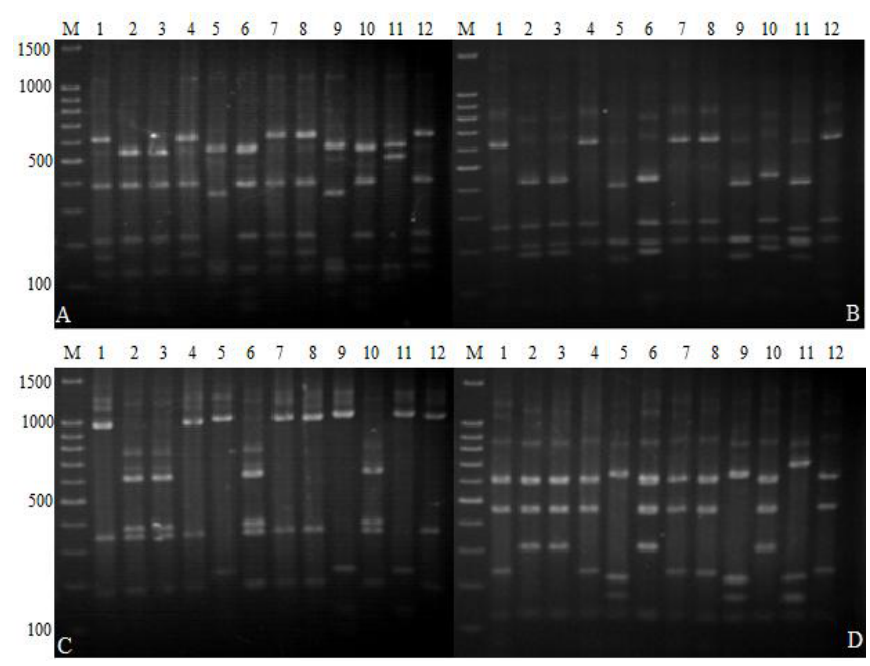
Figure 4. 16S-RFLP patterns obtained from restriction digestion gel photos with Alu I, Hae III, Hinf I, and Msp I. Lanes (1–12) represent the 16S-RFLP groups 1, 3, 5, 6, 9, 11, 13, 15, 18, 21, 23 and 24. Lanes M are the marker 100 bp DNA ladder; A, B, C, and D represent restriction digestion gel photos with Msp I, Alu I, Hinf I, and Hae III.